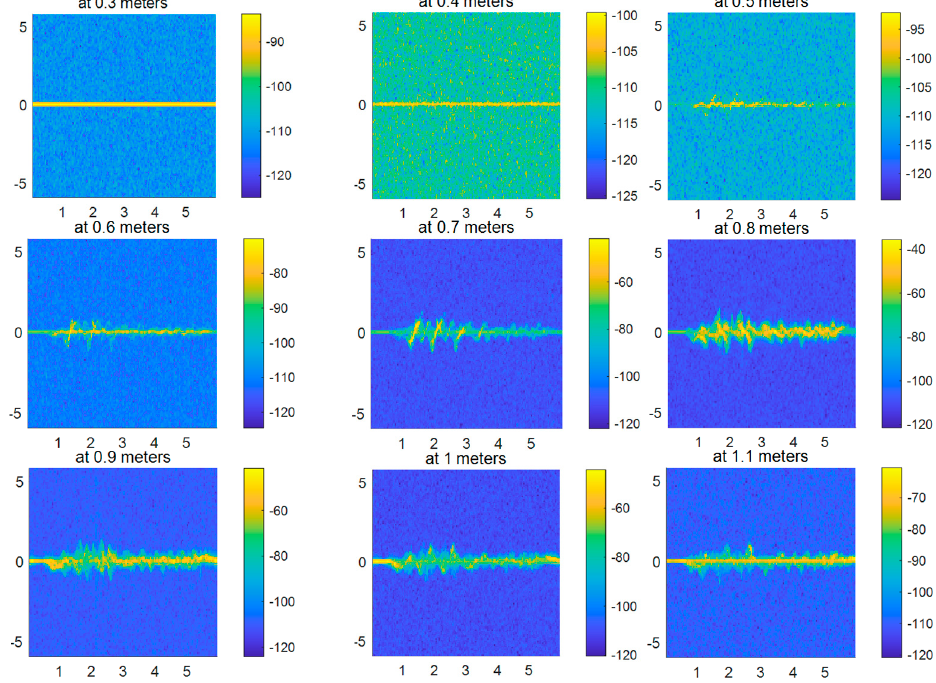
Figure 2. Distance target of 0.30 m to 1.10 m for the micro-Doppler characteristic spectrum.